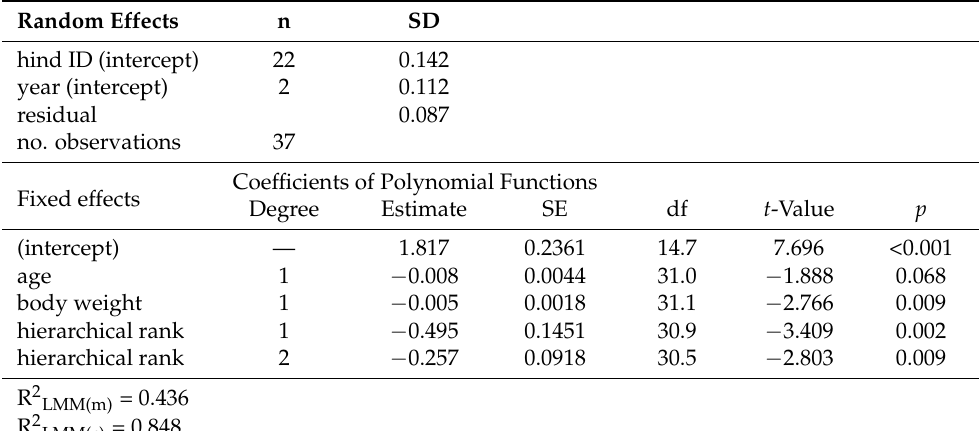
Table 3. Coefficients and statistics of a polynomial mixed model on the response of pelt biting to the hierarchical rank in red deer hinds, controlling for hind weight (body weight, kg), hind age (age, yr), hind identity (hind ID), and year. R 2 marginal, variance accounted for by the fixed effects (R 2 LMM(m) ); R 2 conditional, variance accounted for by random and fixed effects (R 2 LMM(c) ).